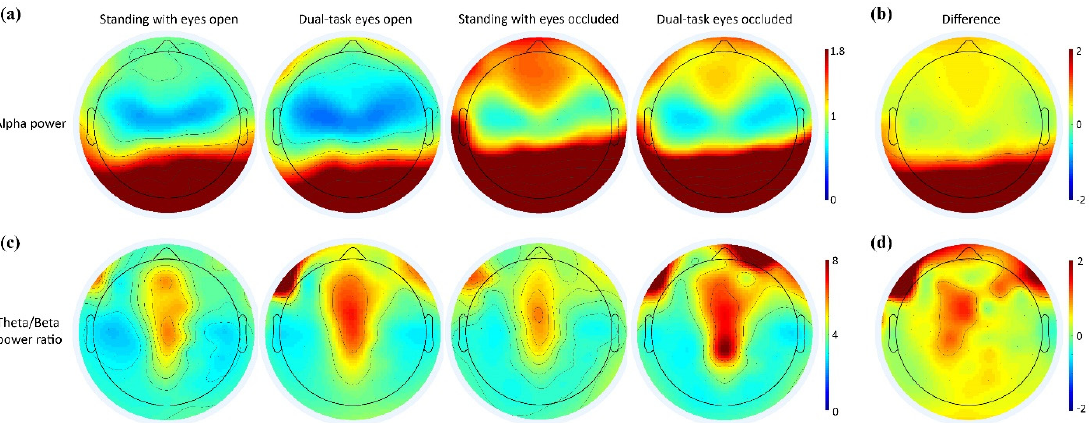
Figure 5. Scalp maps of alpha power ( µ V 2 /Hz) and theta/beta power ratio distribution across the channels. Warmer or cooler colors indicate more or less power in each frequency band, respectively.